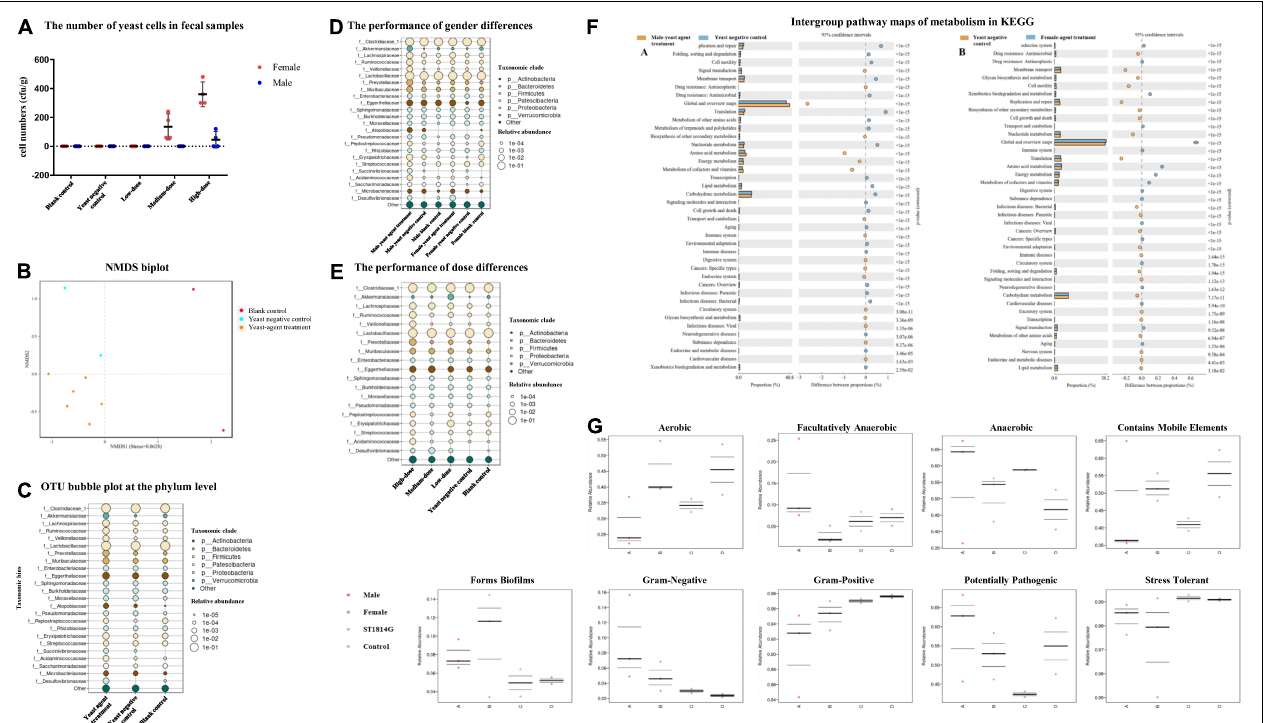
FIGURE 5 | Effects of the yeast agents’ use on the gut microbiome of mice. (A) The number of yeast cells in fecal samples. Fecal samples were harvested from 4 to 24 h after oral gavage. Feces were cultured in yeast extract-peptone-dextrose (YPD) liquid by diluting 0.2 g of feces in 1.2 ml YPD liquid at 30 ◦ C for 4 h. A 100 µ l mixed aliquot was then plated onto YPD agar and repeated three plates. The number of ST1814G-S (RBD-FP) yeast cells was established after 48 h of incubation. (B) Non-metric multidimensional scaling (NMDS) biplot of a Bray-Curtis dissimilarity matrix analysis. The yeast agent and blank control groups indicated a significant difference ( P < 0.05) with the ordination. (C) Bubble plots showing the relative abundance of indicator operational taxonomic units (OTUs) in each of the three groups of the sampling stations. The bubble size indicates the relative abundances (%) of each OTU in the sampling station. Consensus taxonomic groups of each indicator OTU are presented on the left side of bubble plots. Bubble plots show the relative abundance of indicator OTUs in gender-based groups (D) , and dosage groups (E) . (F) Intergroup pathway maps of metabolism in KEGG. Comparison between gender in high-dose treatment with ST1814G host cell. (G) Intergroup difference proportion at the family level. BugBase determines the ratio of phenotypes in each microbiome sample. The phenotypic types included Gram staining, oxygen requirement, biofilm-forming, potential pathogens, and containing mobile